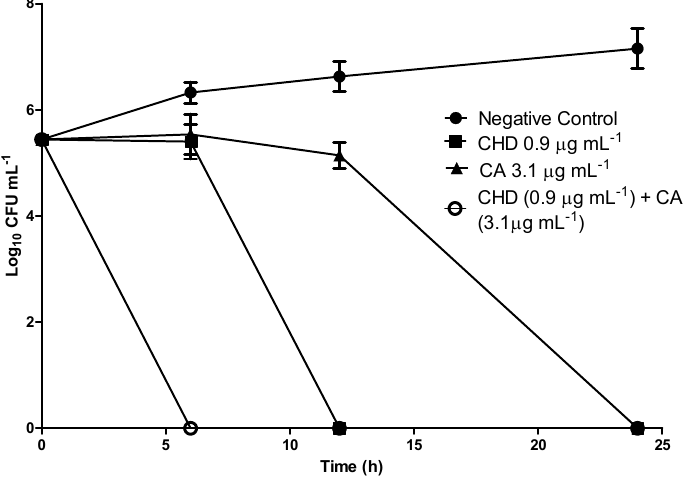
Figure 2. Time-kill curves for CA, CHD, and CHD + CA against P. gingivalis